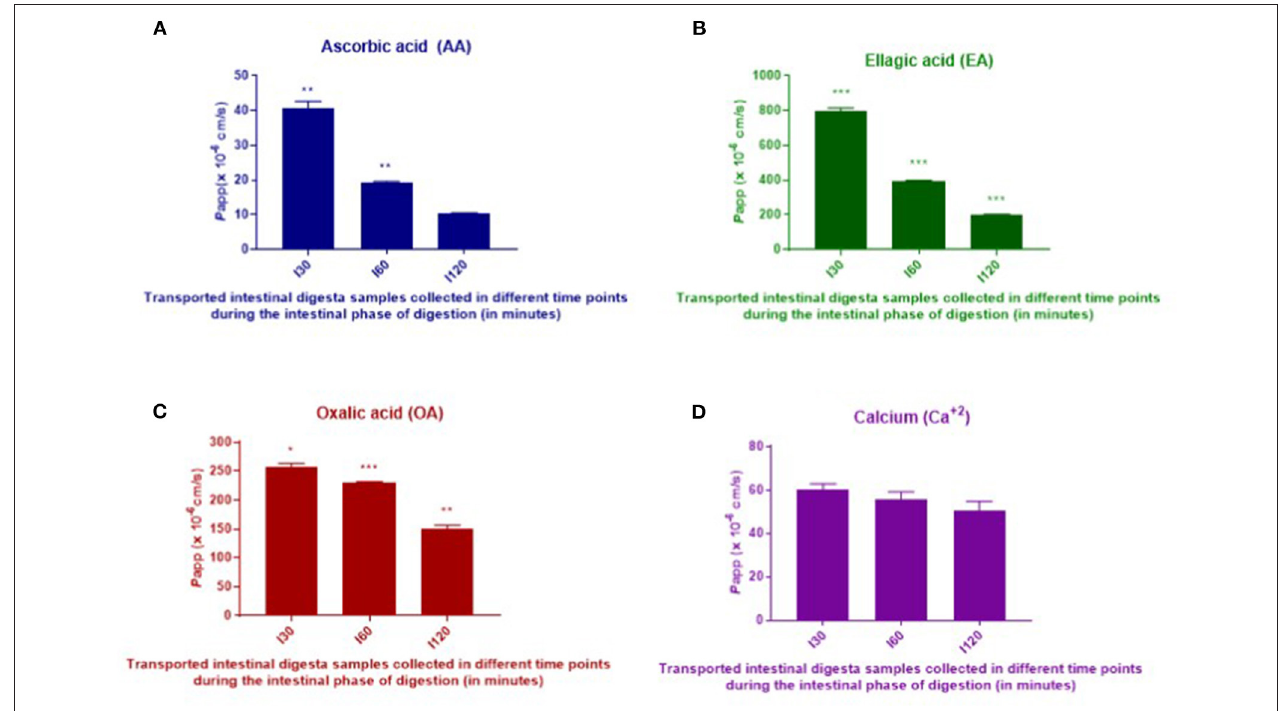
FIGURE 4 | In vitro intestinal absorption of AA (A) , EA (B) , OA (C) , and calcium (D) from digested T. ferdinandiana powder across Caco-2-HT29-MTX-E12 cell barriers. Caco-2-HT29-MTX-E12 cocultures grown on transwells were incubated with I30, I60, and I120 intestinal digesta at 10:1 dilution for 2h. Results are expressed as the mean ± SEM of 2 determinations ( n = 2). One-way ANOVA followed by Tukey’s multiple comparison tests was performed to compare apparent permeability ( P app) for each compound from I30, I60, and I120. Asterisks (*) indicate differences that are statistically significant among the applied digesta (I30, I60, and I120) samples within each compound (* p ≤ 0.01, ** p ≤ 0.001, *** p ≤ 0.0001). I30, intestinal 30min; I60, intestinal 60min; and I120, intestinal 120min.